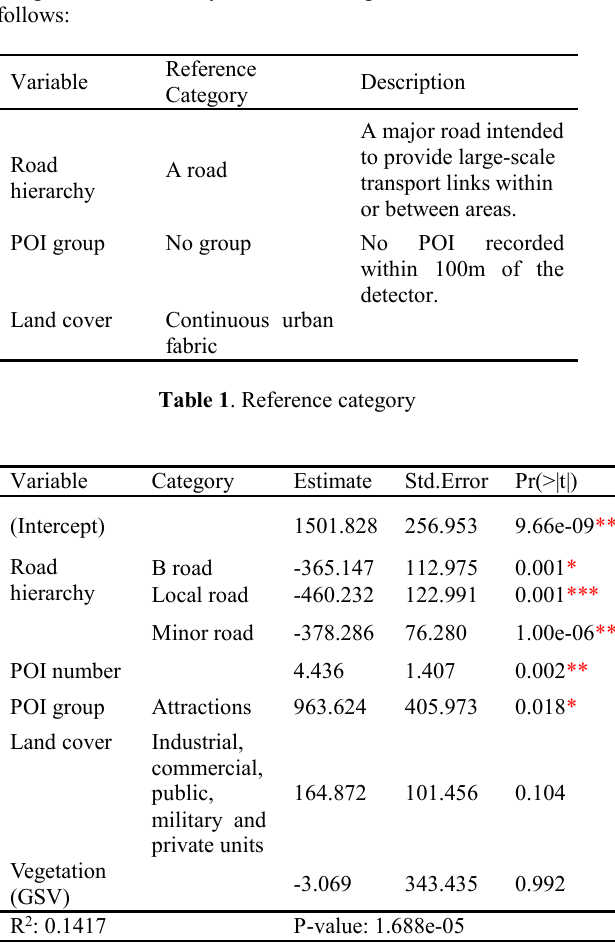
Table 2 . Linear regression model results